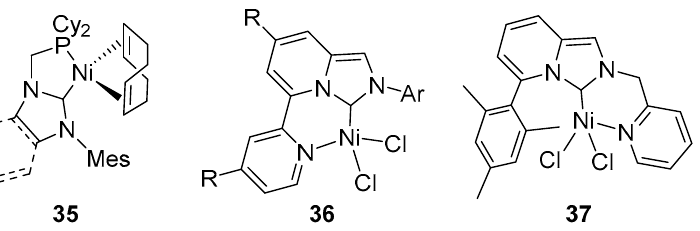
Figure 31. NHCs nickel catalysts 35 – 37 used in acrylate formation from ethylene and CO 2 .